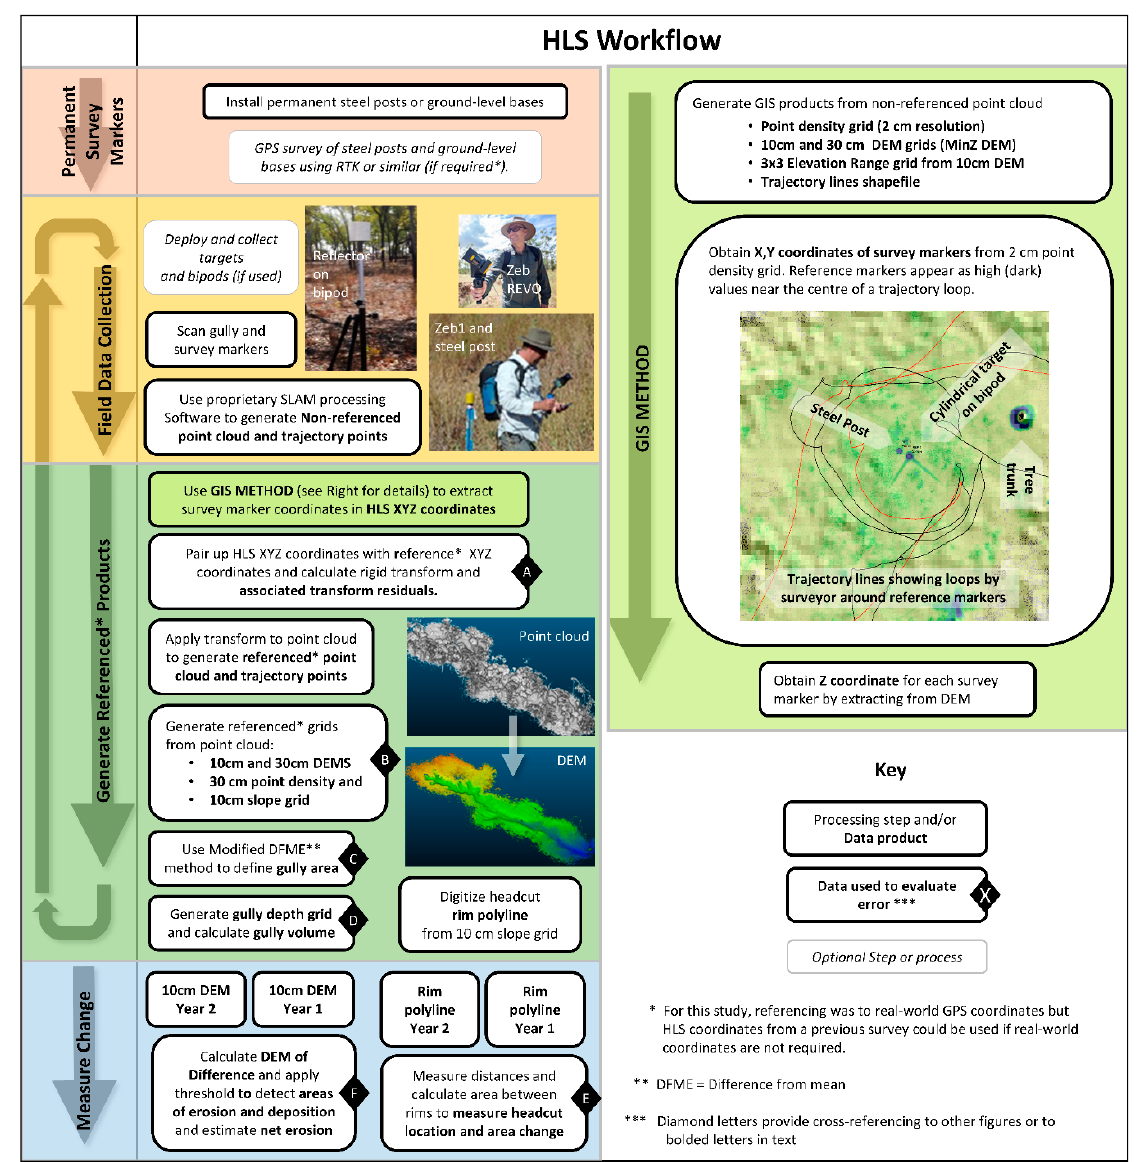
Figure 2. Workflow for HLS gully analysis. This workflow was developed over the 5-year study period. In the GIS screen shot shown in the GIS Method, the 2 cm point density grid is shown in yellow-green-blue (dark blue is high density) overlain on the shaded 10 cm DEM. Survey markers, are visible as small discrete high density dots in the 2 cm point density grid. If the surveyor walked around these markers, evident as loops in the trajectory in the GIS, then markers were easily discriminated from objects such as tree trunks or other vertical structures. Diamond letters provide cross-referencing to bolded letters in the text or to other figures and indicate the data (in bold font) used to evaluate HLS error in this paper.